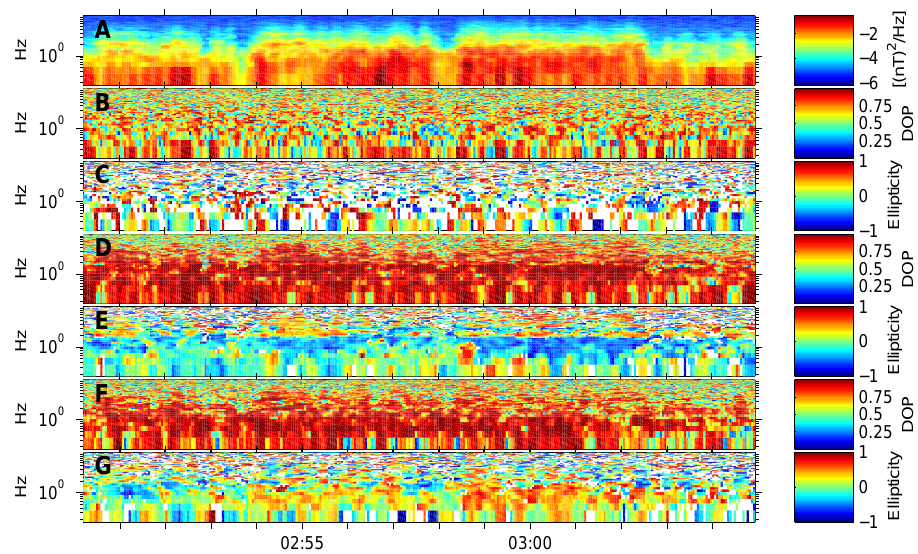
Fig. 3. Polarization in a field-aligned coordinate system as a function of frequency. Panel (a) shows the Fourier transform spectrogram of the FGM magnetic field. Panel (b) shows the degree of polarization and panel (c) the ellipticity for the perpendicular components. Similarly for the sunward-pointing perpendicular and the parallel components in panels (d) and (e) . Finally, panels (f) and (g) shows the same parameters for the duskward-pointing perpendicular and the parallel components.